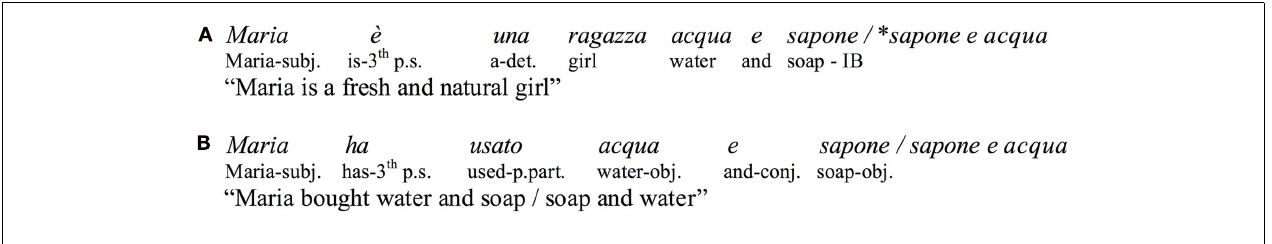
FIGURE 1 | (A) Example of irreversible binomial. (B) A corresponding non-binomial